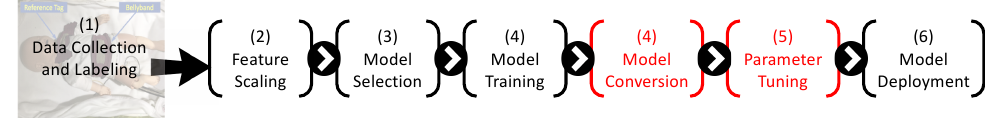
Figure 8. Seven-stage pipeline, including the two new stages to process and optimize the SNN